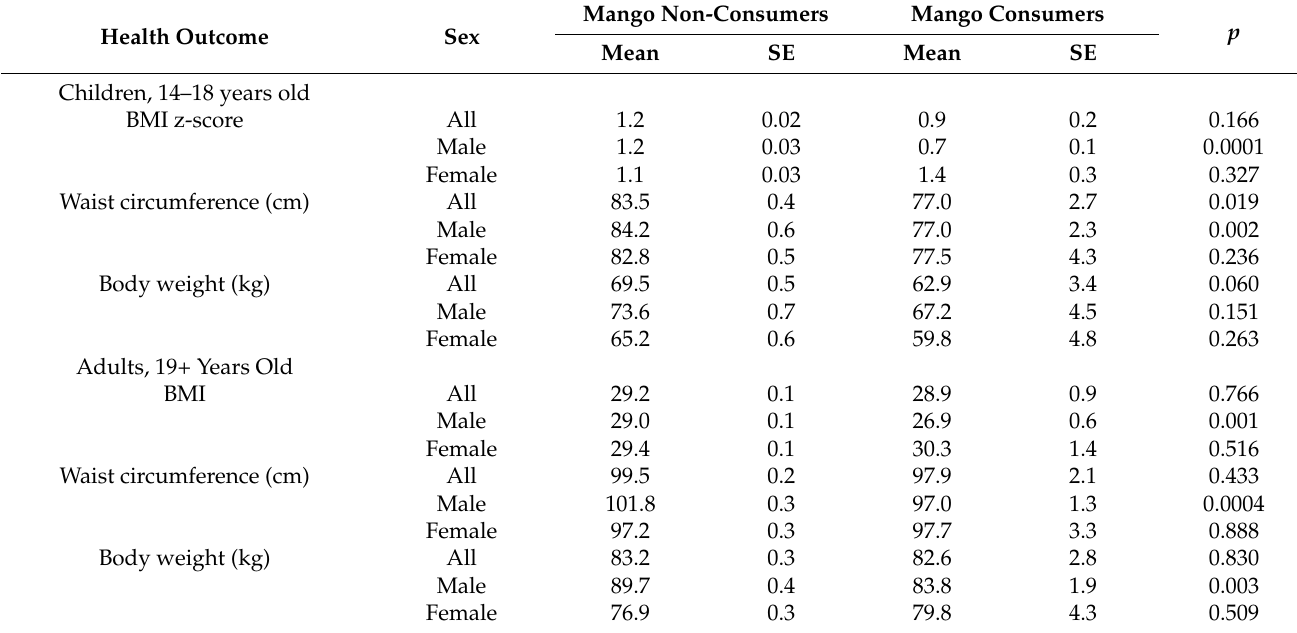
Table 6. Weight-related health outcomes in mango consumers and non-consumers, for both children and